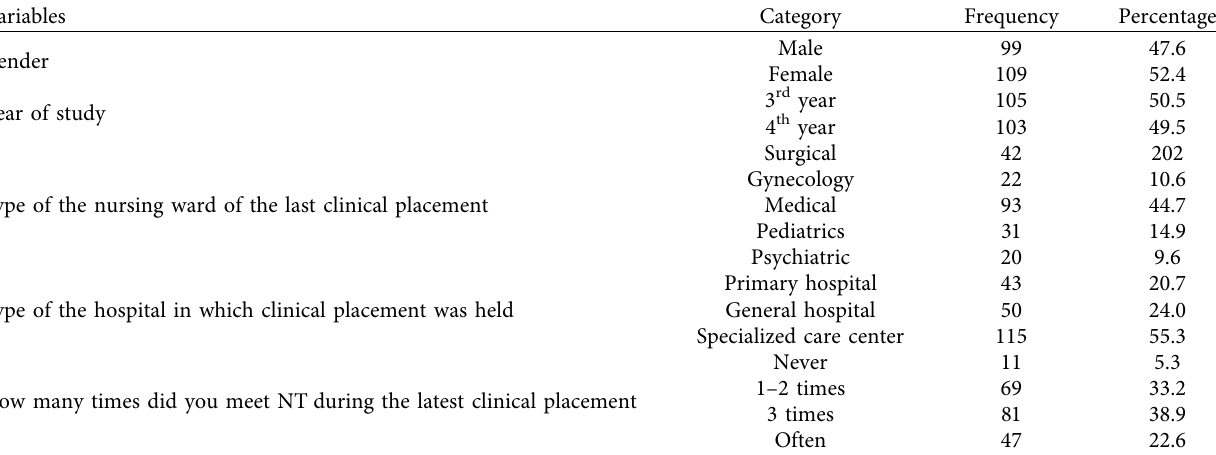
Table 1: Distribution of the study participants across demographics ( n � 208).